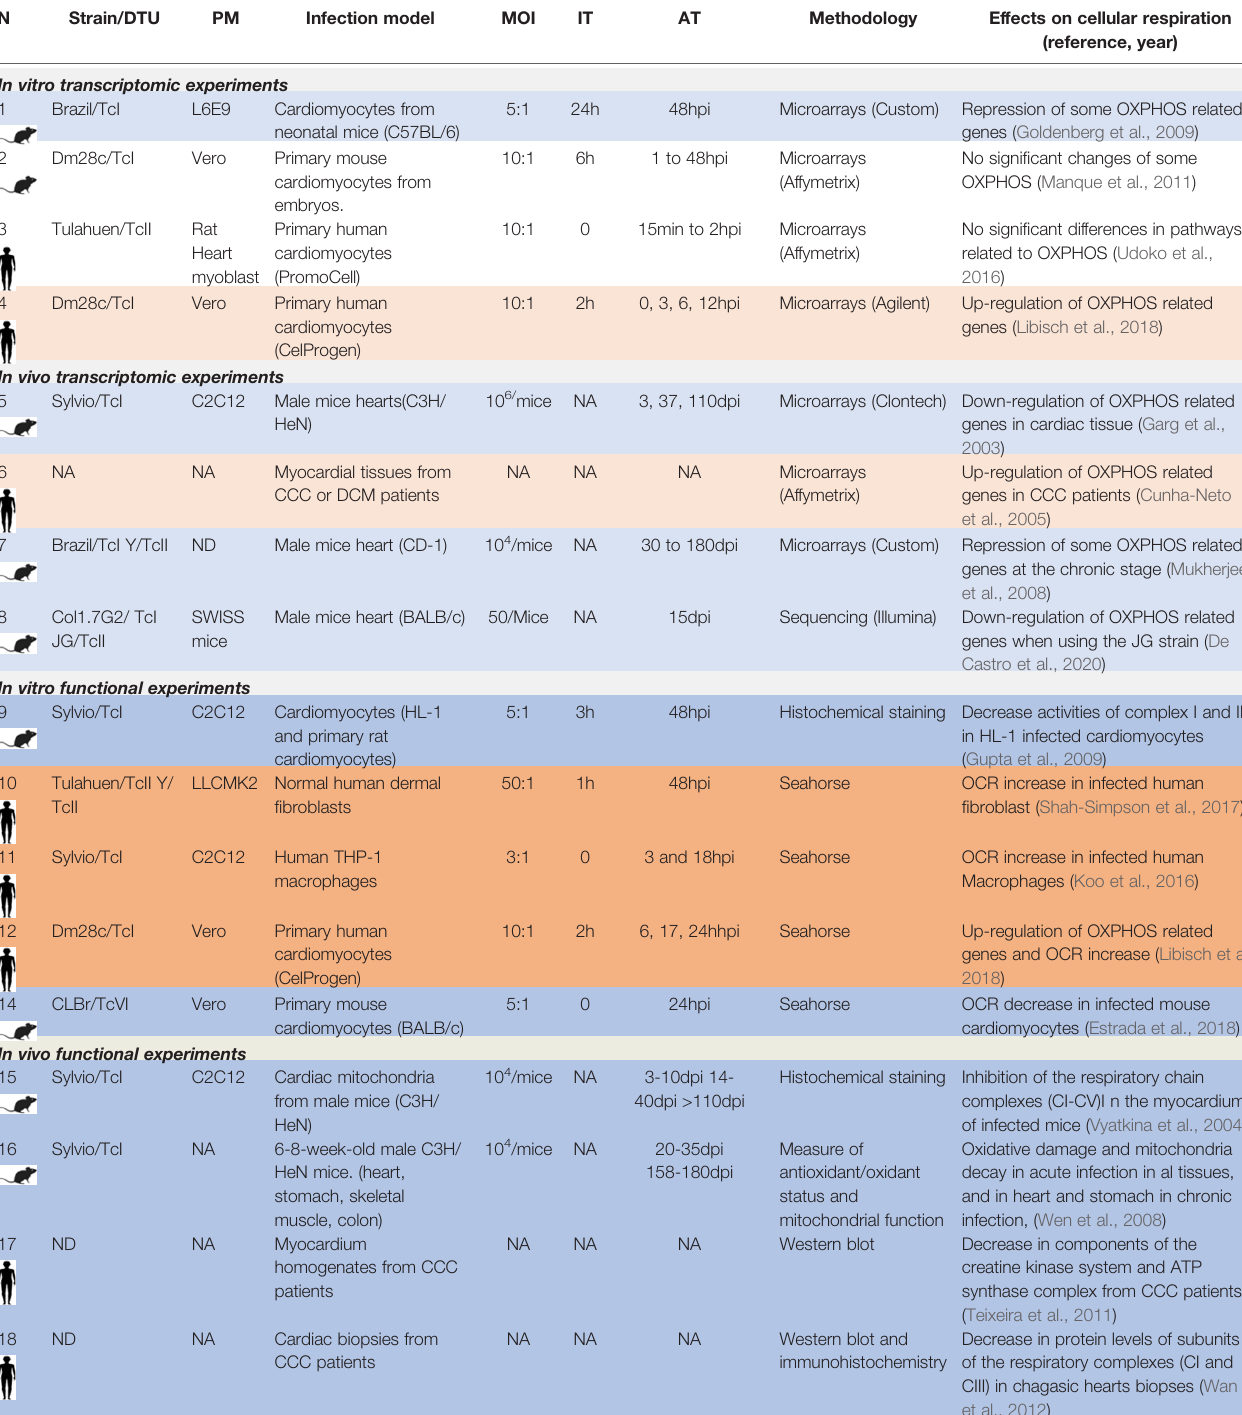
The blue and orange color show whether the study found a decrease or an increase in transcriptomic (light color) and functional (dark color) respiration in T. cruzi infected cells, respectively. (PM, Parasite Propagation Model; MOI, Multiplicity of Infection; IT, interaction time; AT, Analyzed time; NA, Not Applicable; ND, No Data available, OXPHOS, Mitochondrial oxidative phosphorylation system; C2C12, mice myoblast cells; LLCMK2, Kidney cells from Macaca mulatta; Vero, Kidney cells from Cercopithecus aethiops; Seahorse, Seahorse extracellular fl ux